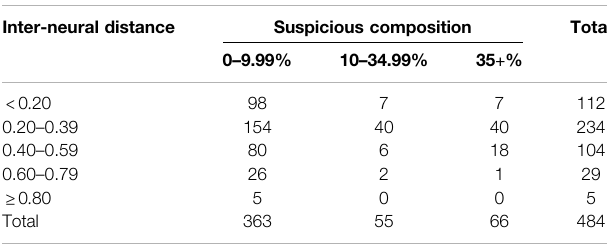
TABLE 2 | Fifth-fold cross-validation SOM neurons inter-neural distances against their suspicious accounts